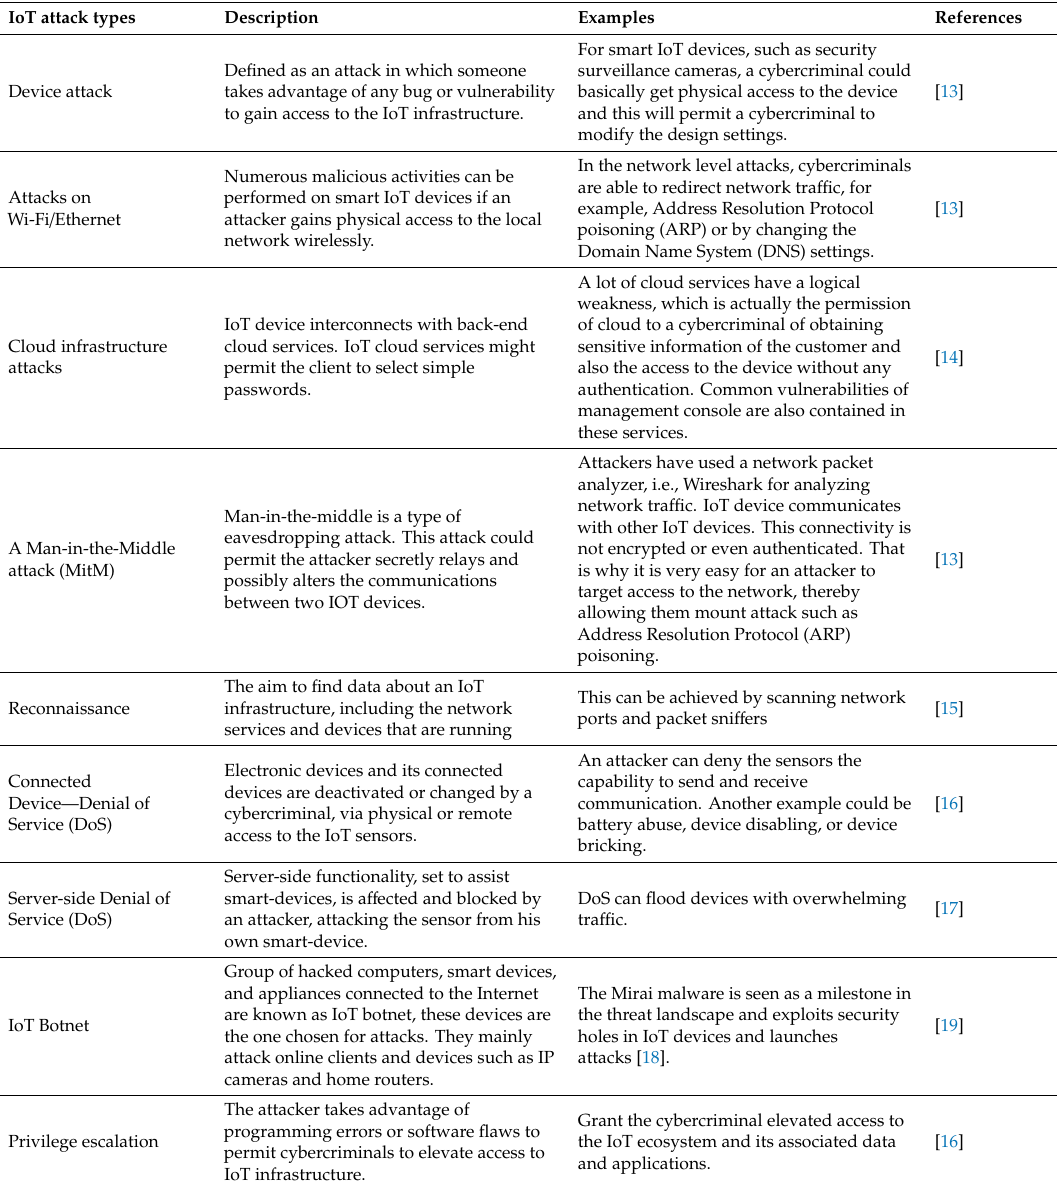
Table 1. Common attack types which are used to attack smart